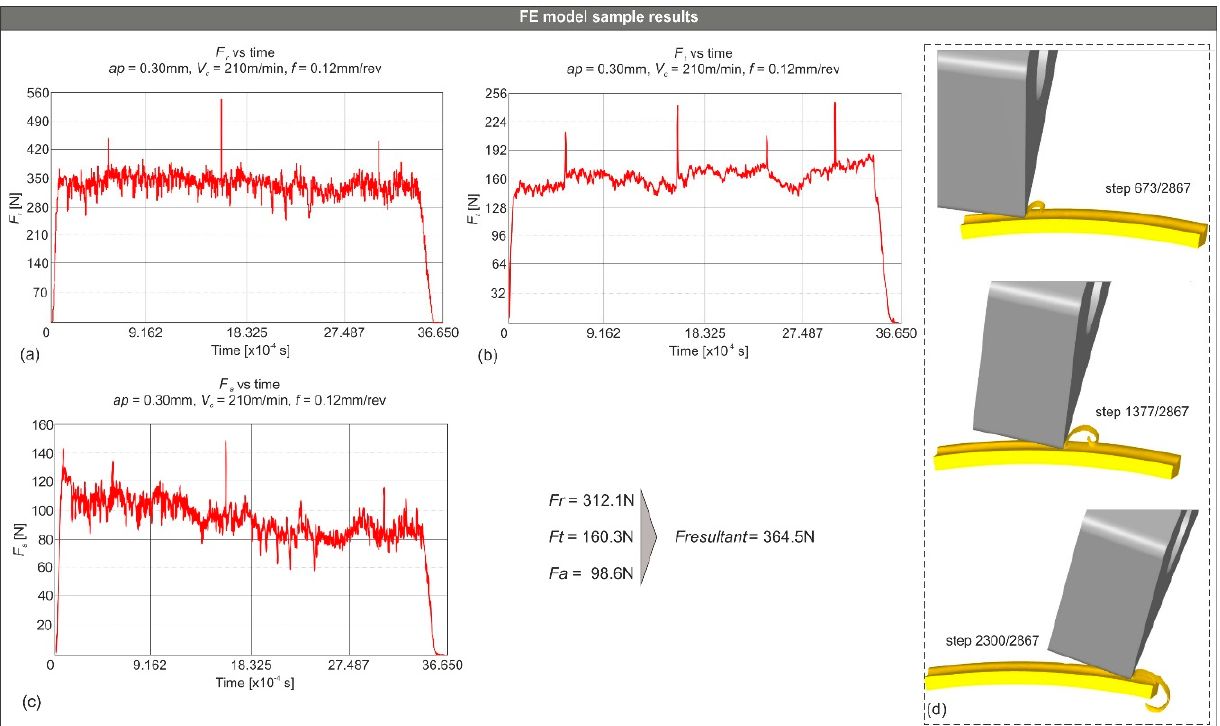
Figure 3. Sample force vs. time diagrams for 0.30 mm depth of cut, 210 m/min cutting speed, and 0.12 mm/rev feed; ( a ) radial force component, ( b ) tangential force component, ( c ) feed force component, and ( d ) the evolution of the chip for the same conditions.